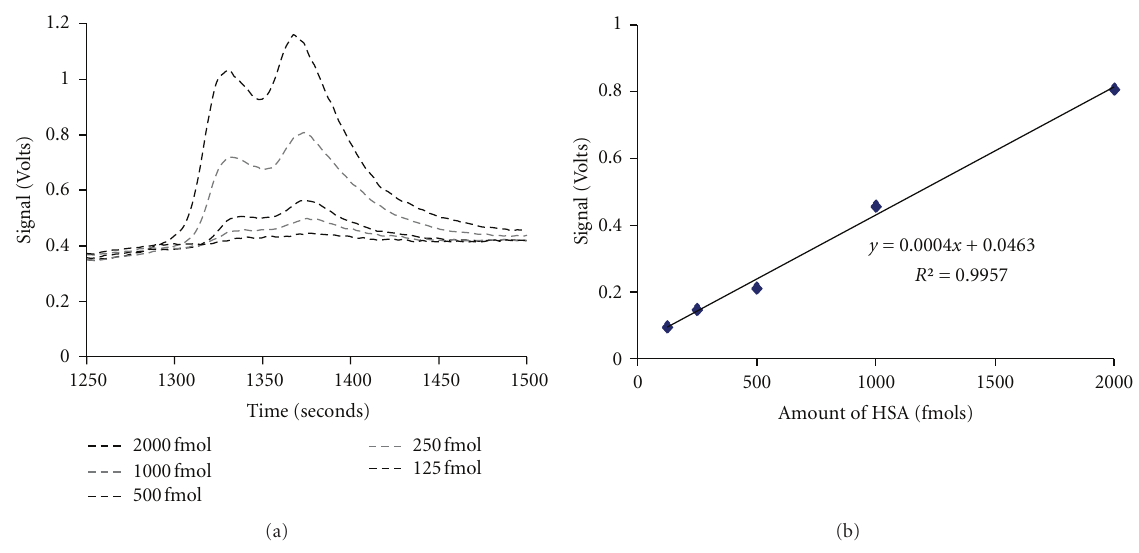
Figure 1: (a) Protein profiles of Human Serum Albumin (HSA) at di ff erent concentrations; (b) calibration curve for HSA.